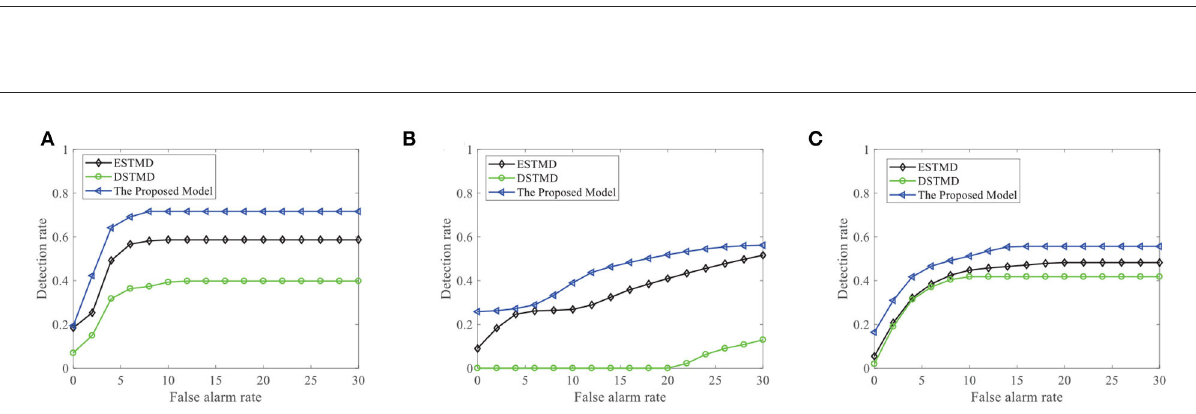
F A curves of the three models for different background with a −